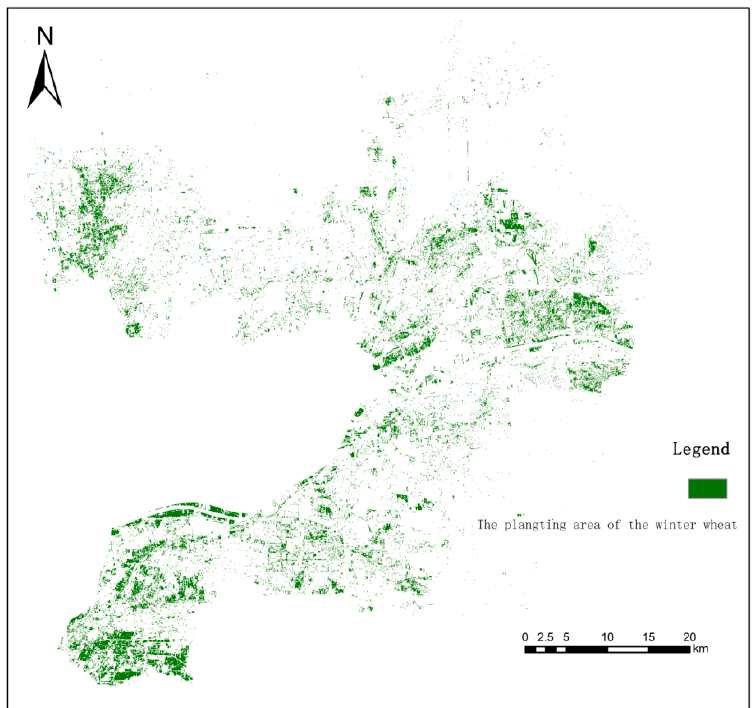
Figure 3. Distribution of winter wheat in the study area in 2018.